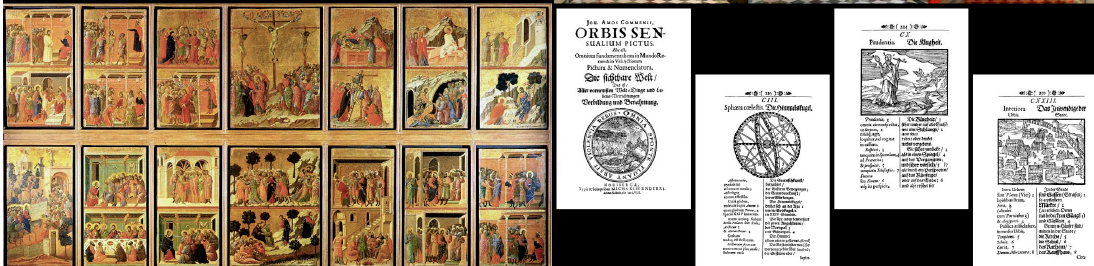
Figure 4. Images that build narrative paths (visual storytelling) and educational images, capable of forming knowledge and know-how (didactic iconography and